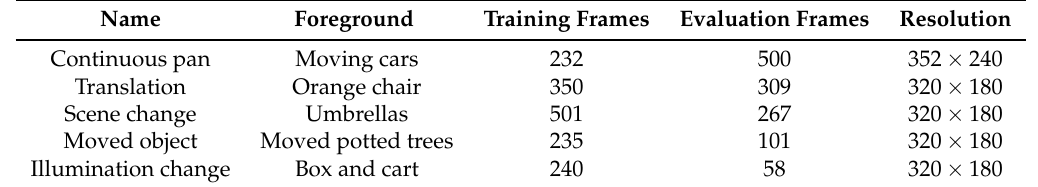
Table 1. Summary of our dataset.